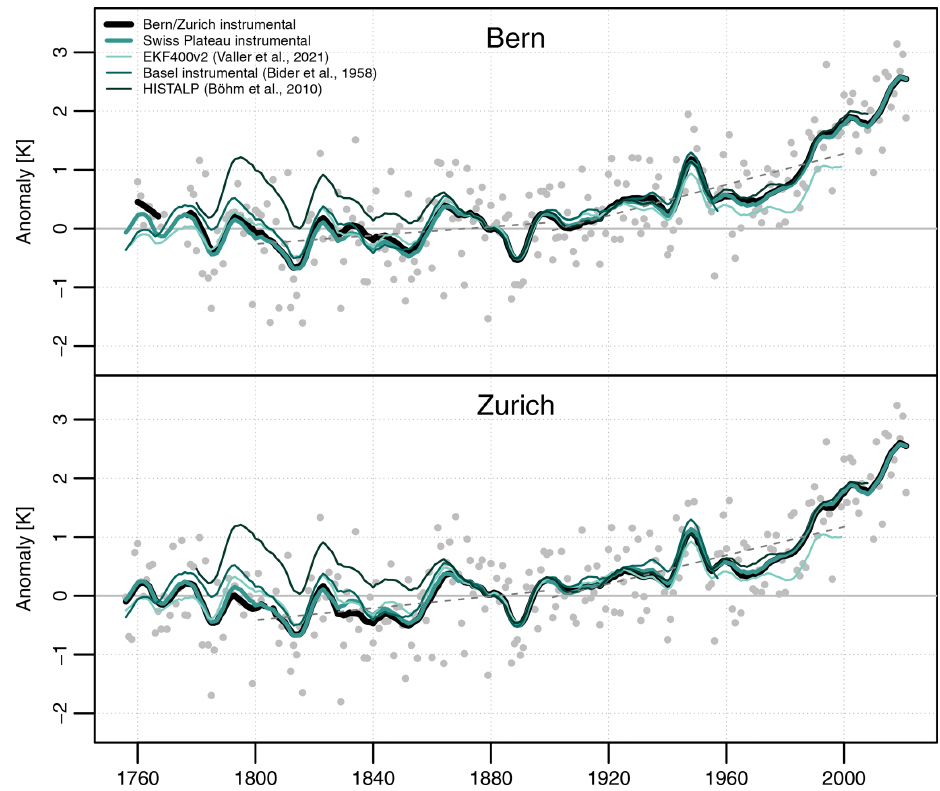
Figure 14. Smoothed time series of the annual mean temperature anomalies (with respect to the 1871–1900 average) for Bern and Zurich, as well as their average (thick lines). The thin lines show the annual mean temperature anomalies from the nearest grid point in EKF400 and HISTALP, as well as in the Basel instrumental series. The dashed lines show the linear trends for the 19th and 20th century in the Bern and Zurich series. All data series were smoothed using a Gaussian filter with σ = 3 years. Dots represent the unsmoothed annual anomalies for Bern and